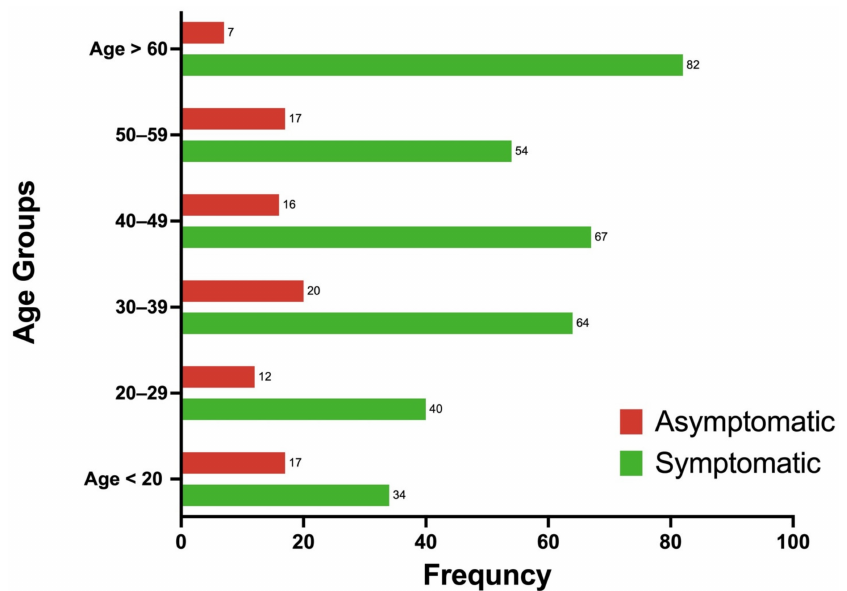
Figure 1. Age group distribution of COVID-19 cases by symptom status (asymptomatic vs. symp- tomatic) shown as percentages. Most patients in this cohort with confirmed COVID-19 were older than 60 years (19%); 21% of the cohort was asymptomatic, whereas 79% was symptomatic. The highest percentage of asymptomatic patients (5%) was observed in the age group of 30 to 39